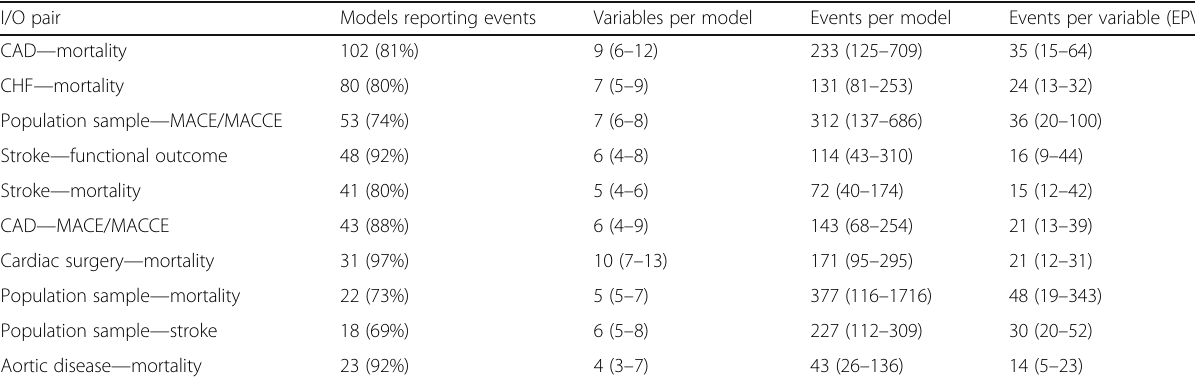
Table 2 Index condition/outcome (I/O) pairs of de novo models I/O